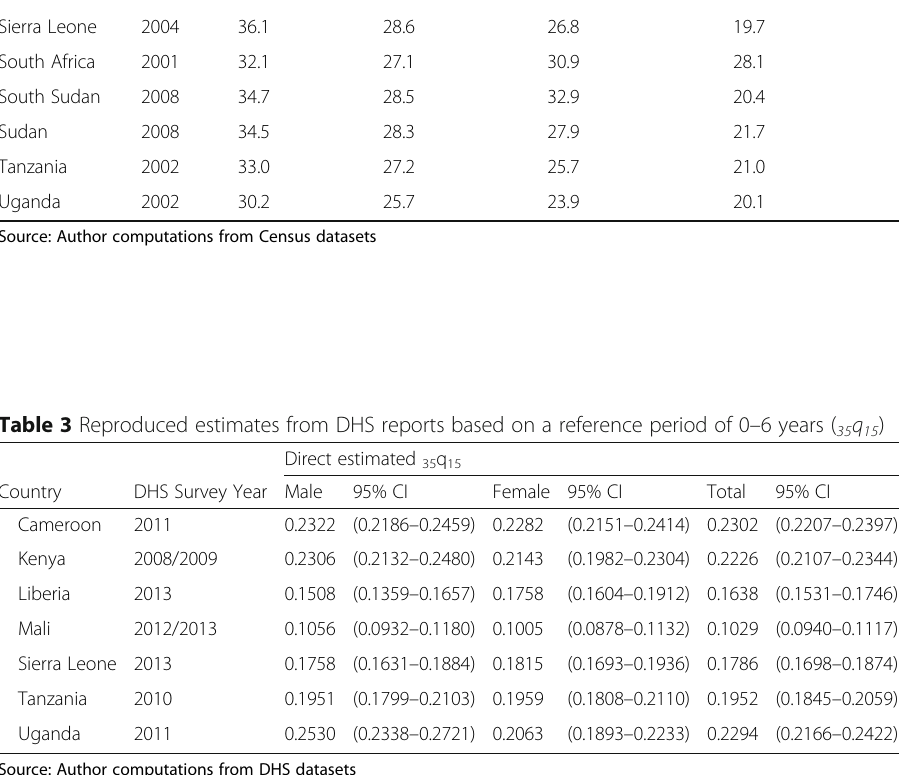
Table 4 Probability of dying between age 15 and 60 years ( 45 q 15 ) estimated from DHS sibling histories Directly estimated 45 q 15 INDEPTH model